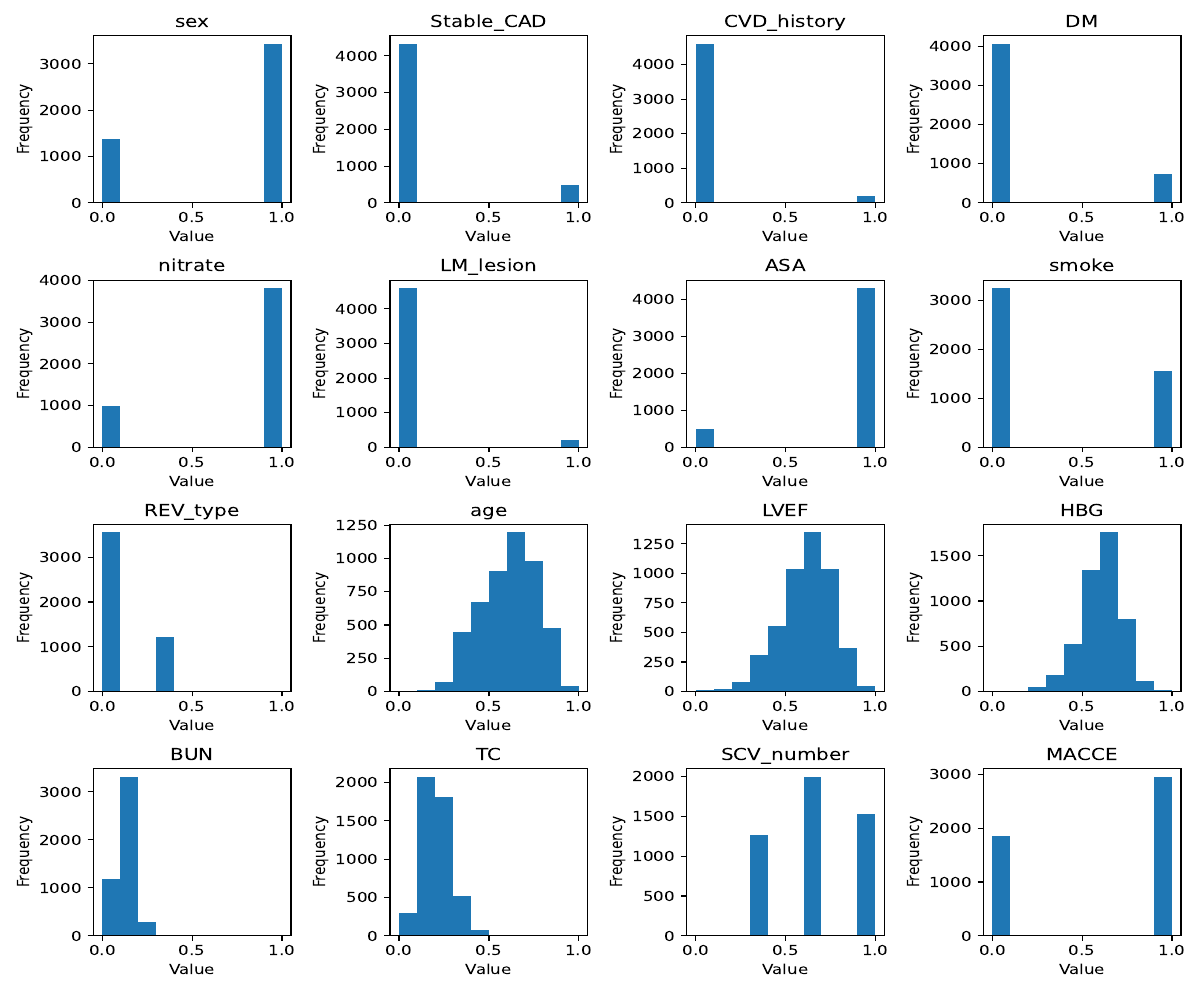
Figure 2. The frequency distribution histogram of